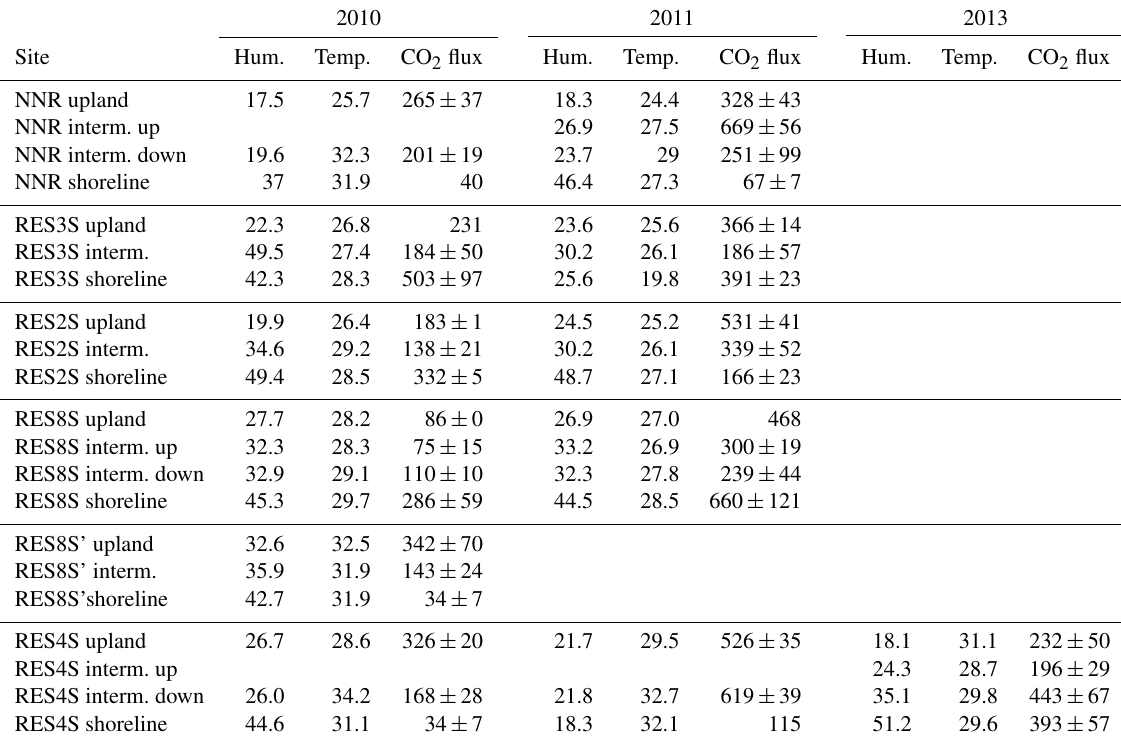
Table 2. Temperature ( ◦ C), relative humidity (%) and CO 2 fluxes (mmolm − 2 d − 1 ) from the soils of the drawdown area of the Nam Theun 2 Reservoir (Lao